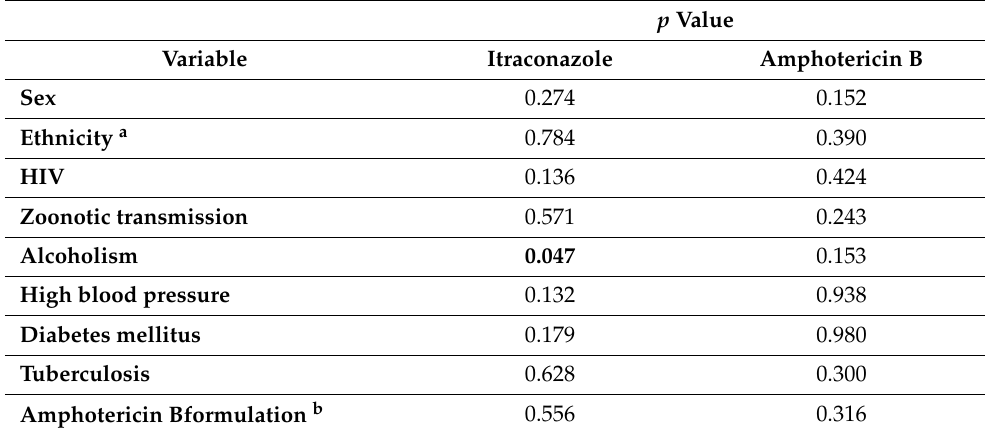
Table 3. Comparison between minimal inhibitory concentration of itraconazole and amphotericin B according to clinical and epidemiological